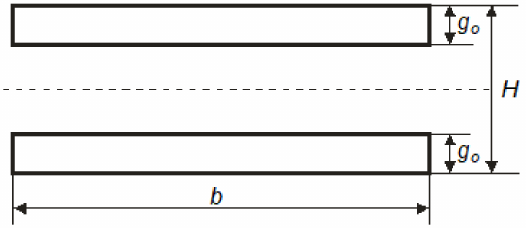
Figure 5. Diagram of a simplified honeycomb paperboard cross-section.